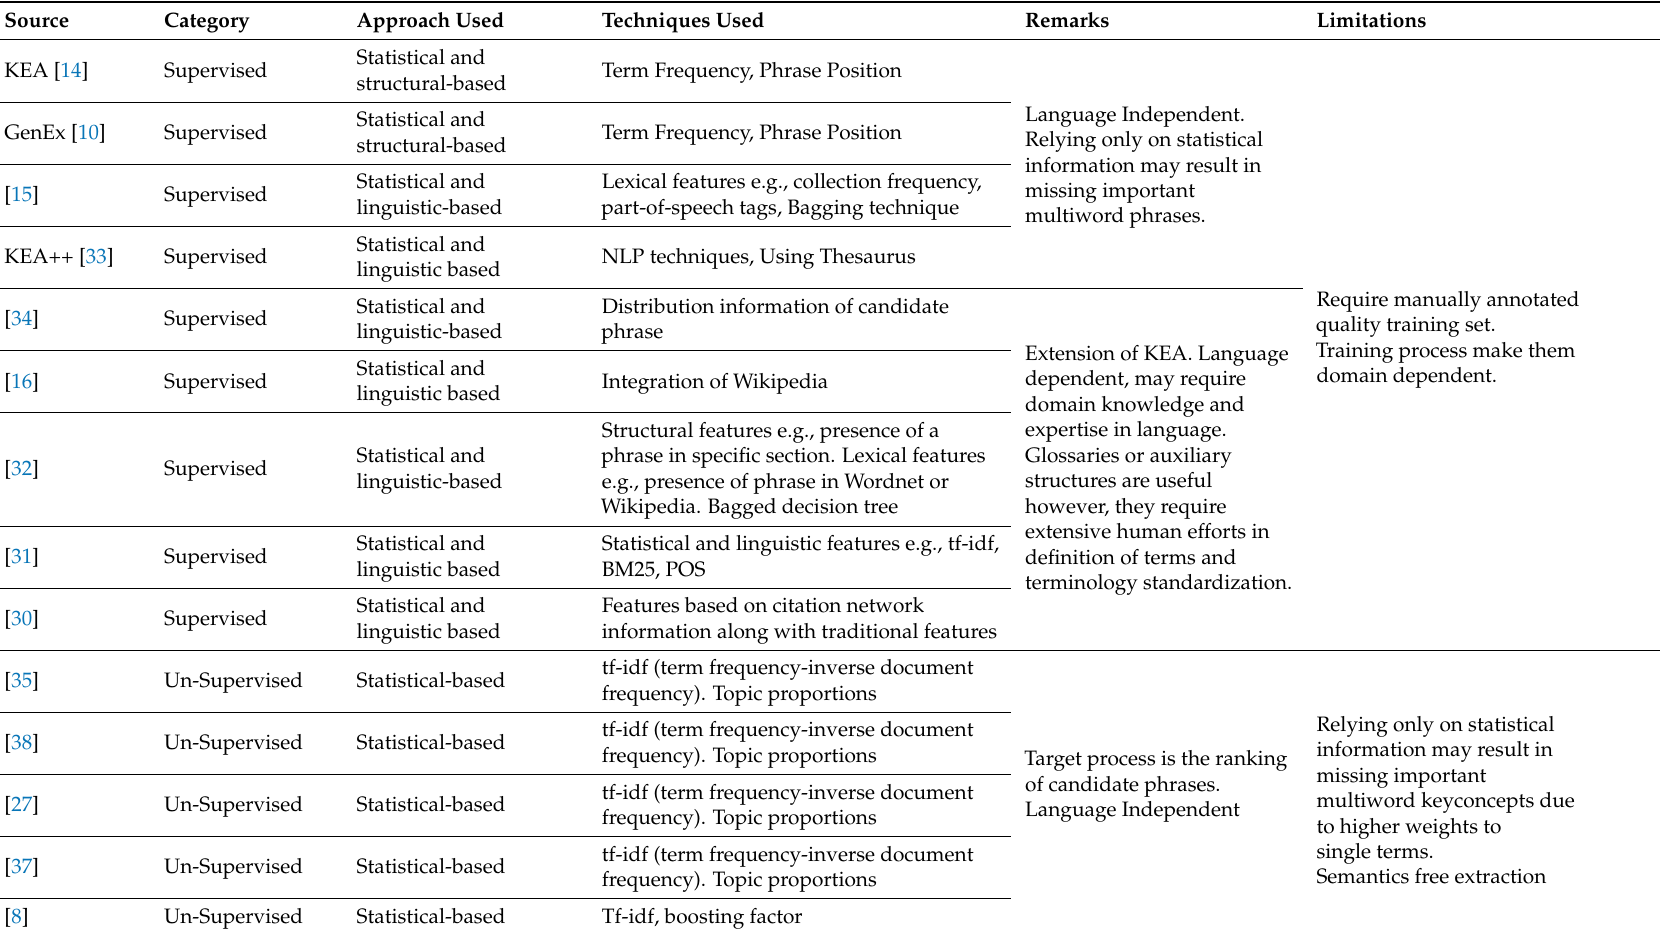
Table A1. Summary of different keyphrase extraction